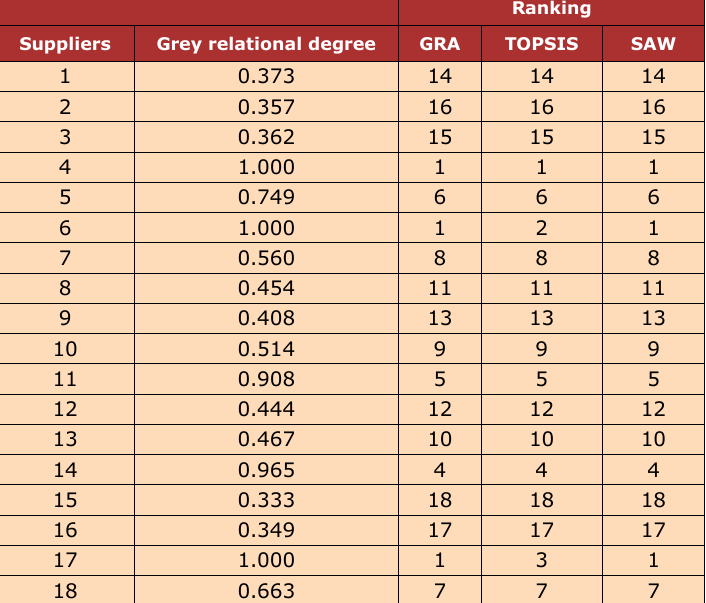
Table 9. The grey relational degree and ranking of